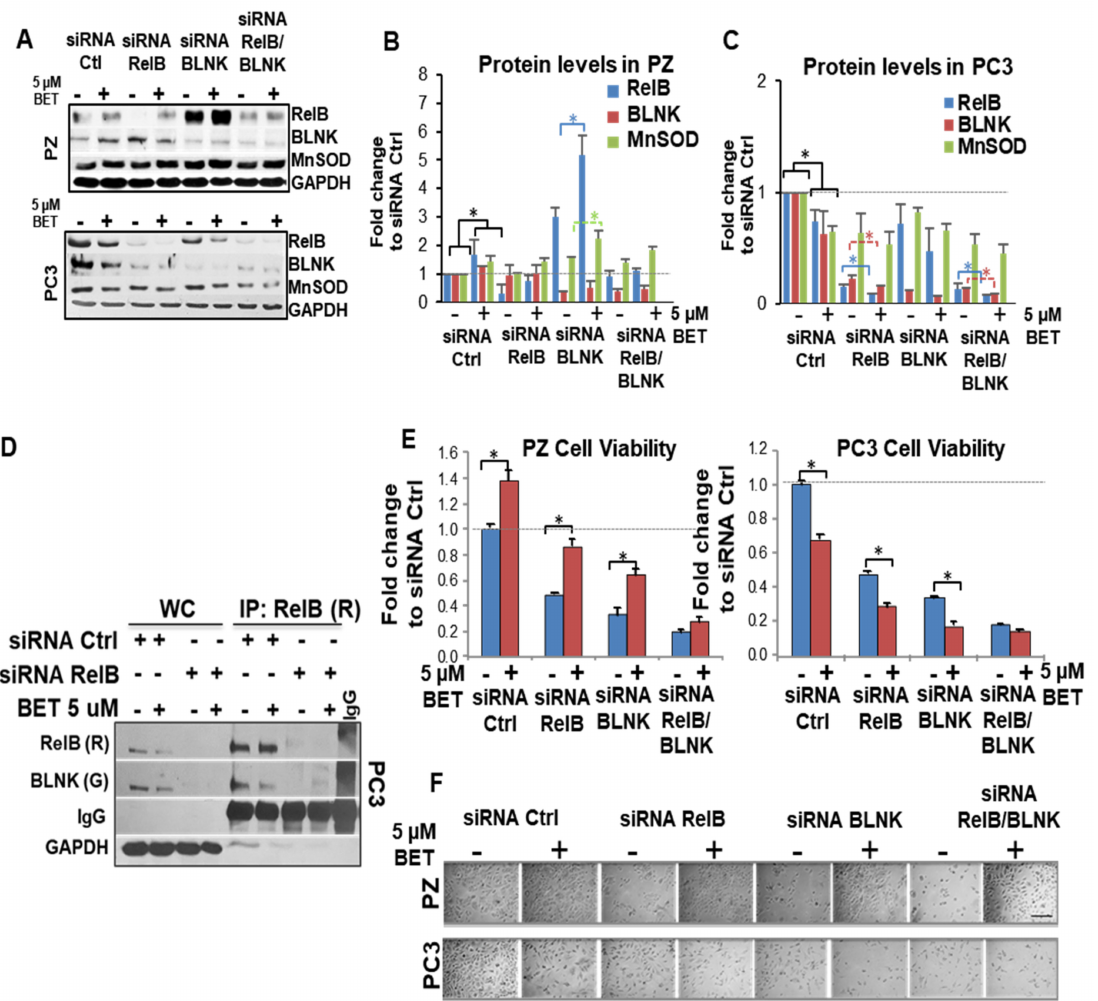
Figure 7. BLNK interaction with RelB is a signal for BET protection of RT-induced injury in normal tissues. Cells were transfected with siRNA (Santa Cruz biotechnology) for 48 h and then treated with BET for 24 h. Western blot analysis ( A ) and protein quantification of ( B ) PC3 and ( C ) PZ cells. n = 2. ( D ) IP analysis confirmed a decrease in RelB:BLNK axis with RelB knockdown. WC = Whole cell lysates. R = Anti-rabbit antibody. G = Anti-goat antibody. ( E ) Trypan Blue assay and ( F ) representative photograph indicates a decrease in cell viability with siRNA against RelB, BLNK, or RelB + BLNK with or without BET treatment. n = 3. * p -value < 0.05 vs. non-BET. Scale bar = 50 µ